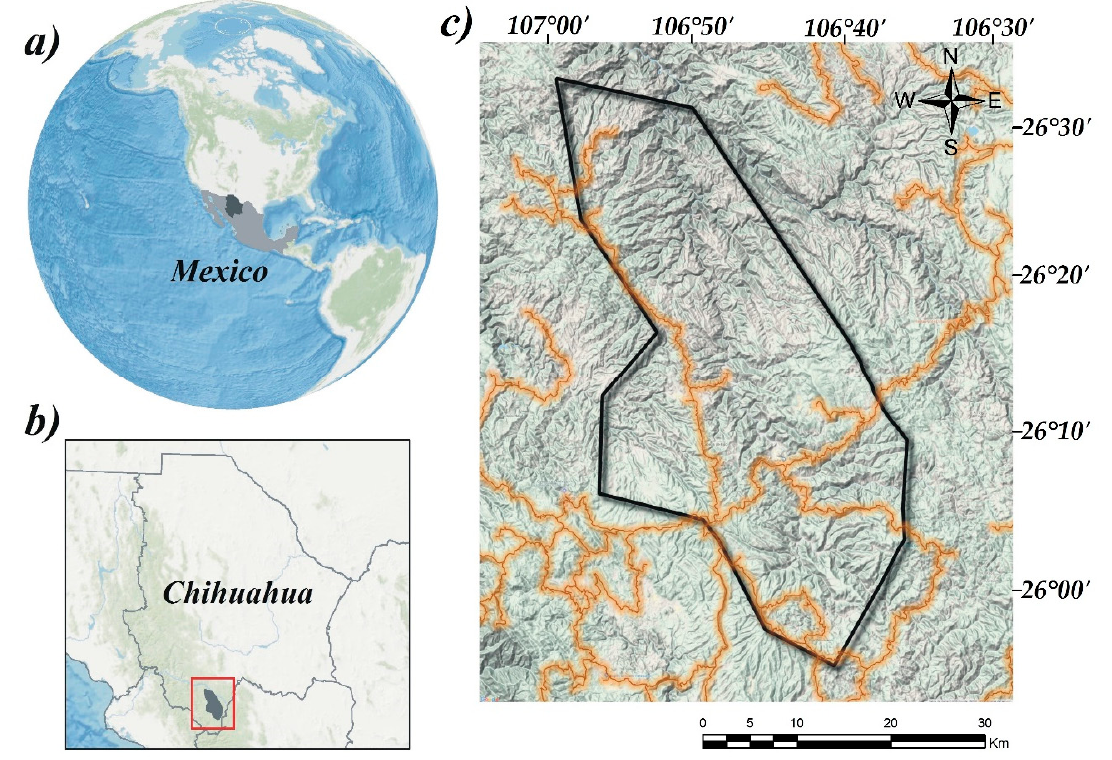
Figure 1. Geographical location of the study area: ( a ) Mexico, ( b ) “Ejido Chinatu” location in Chihuahua, Mexico, ( c ) “Ejido Chinatu”. Boundary of the studied area ( — ), principal roads ( — ).